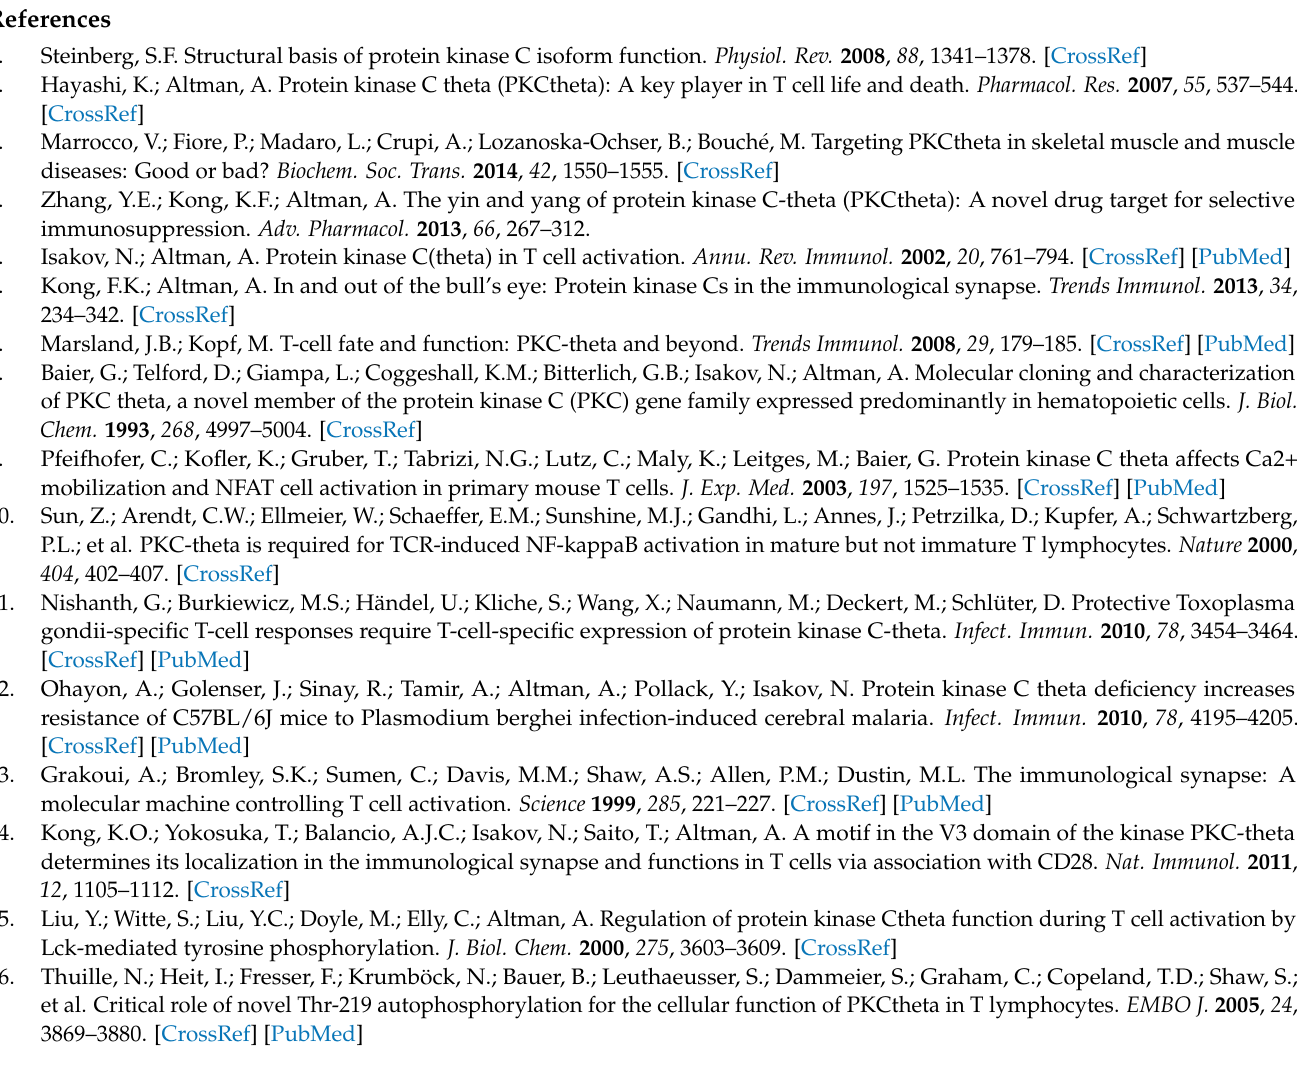
Figure Preparation A.N., K.B.; Writing Review & Editing A.N., Y.Z., K.B. Funding Acquisition